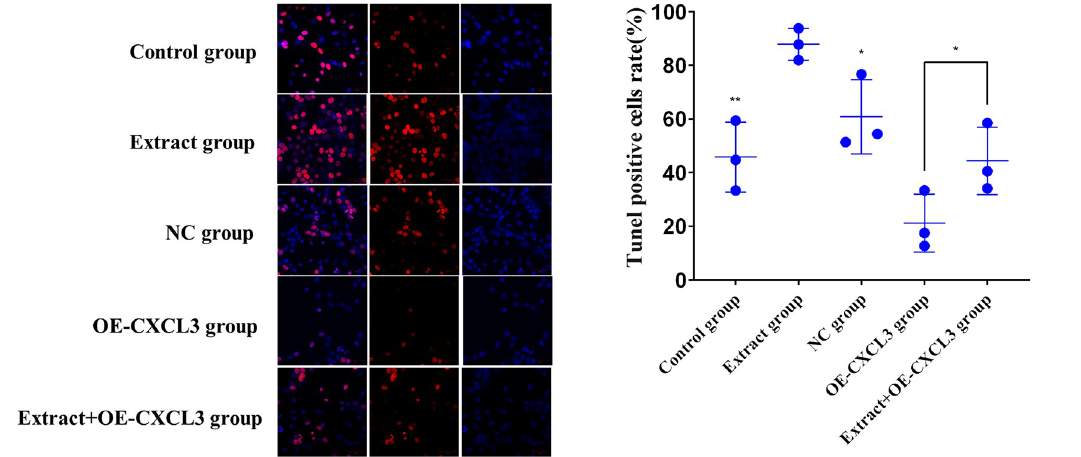
Fig 10. Apoptosis of HepG2 cells in control, extract, and transfection groups. ( a ) × 400 magnification light micrographs of the effects of treatment on HepG2 cell apoptosis. ( b ) TUNEL apoptosis positive cell rates ( � p < 0.05, �� p < 0.01 compared to the extract group).